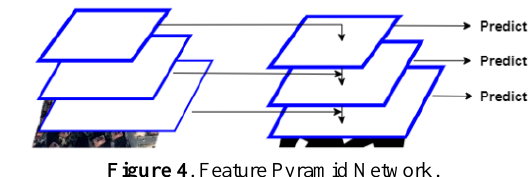
Figure 4 . Feature Pyramid Network.